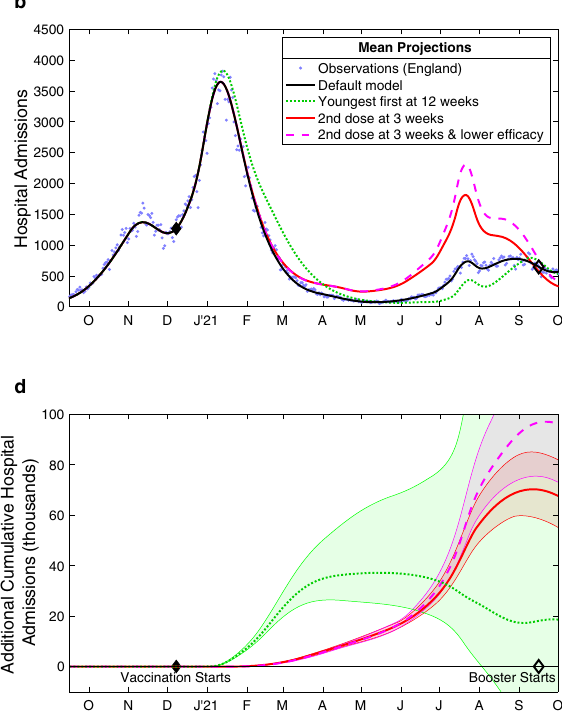
Fig. 1 | Projected changes in daily deaths (a, c) and hospital admissions (b,d) with differing vaccination patterns. a , b Compares the observed levels of severe outcomes (deaths or hospital admissions, blue dots) with (i) the default model projection using the recorded pattern of vaccination (black solid line) and alter- native models where this pattern is perturbed: (ii) the ordering of vaccination is reversed so that younger adults are vaccinated fi rst (green dotted line); (iii) vac- cinations are given 3weeks apart although the total number of daily doses